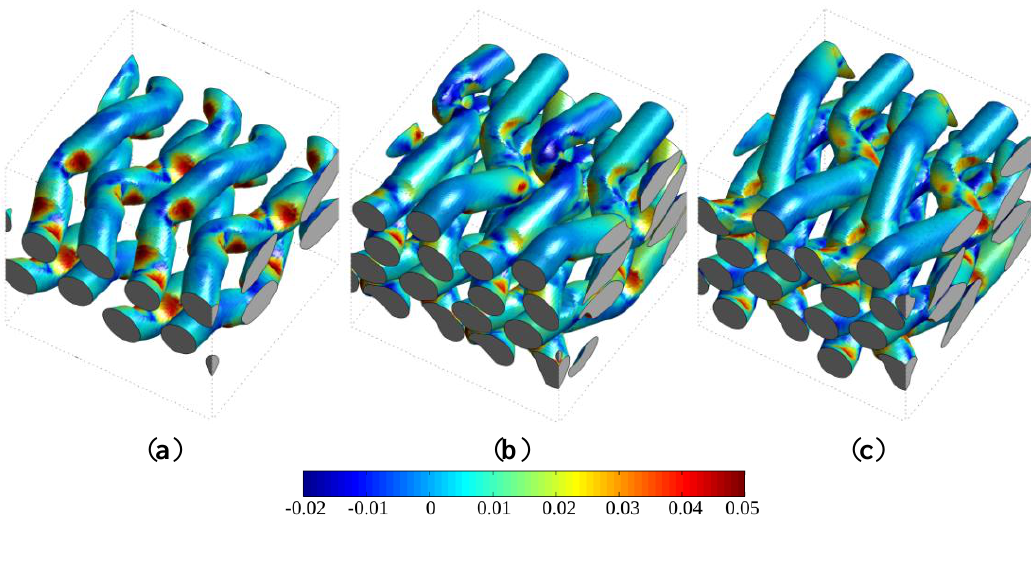
Figure 18. Difference in interfacial tangential stresses between the isotropic (set 1) and transversely isotropic (set 5) assumptions for the behavior of yarns. ( a ) 3D RVE; ( b ) 2.5Da RVE; and ( c ) 2.5Db RVE. The maximum value in the scale is 0.05